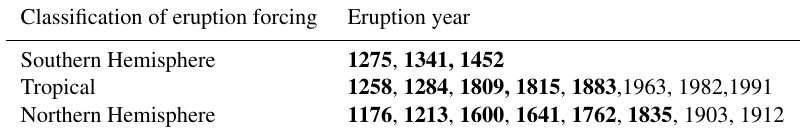
Table 1. List of the volcanic eruptions considered in this study. Eruptions from 850 to 1850 are classified as Southern Hemisphere, tropical and Northern Hemisphere following the methodology of Stevenson et al. (2016). In bold are the SH, tropical and NH pre-20th-century eruptions used in Fig.